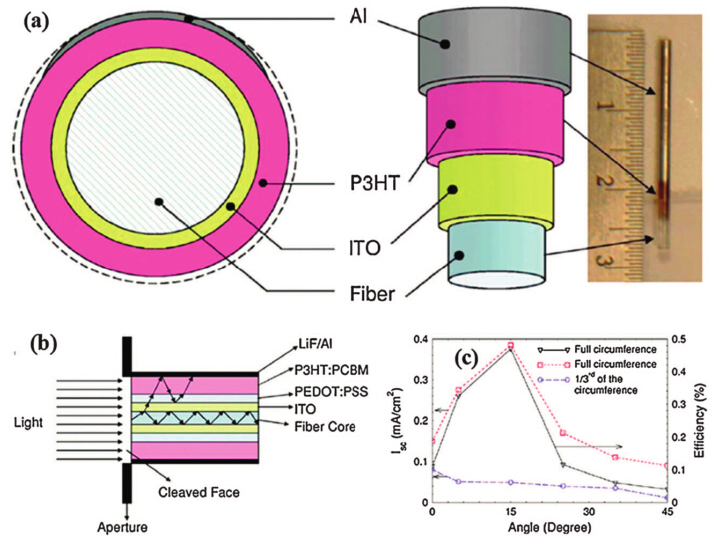
Figure 12. A wire-shaped OPV based on an optical fiber: ( a ) Schematic illustration; ( b ) Light illumination, propagation and confinement inside the active medium through reflection from Al and the refractive index difference between the layers; and ( c ) Dependence of the current density and efficiency on incident angles with respect to the axis of the optical fiber with a diameter of 1.5 mm. Cited from [100]. Copyright 2007, American Institute of Physics.